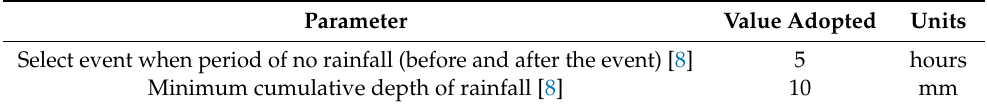
Table 2. Criteria adopted for selection of the storm events.